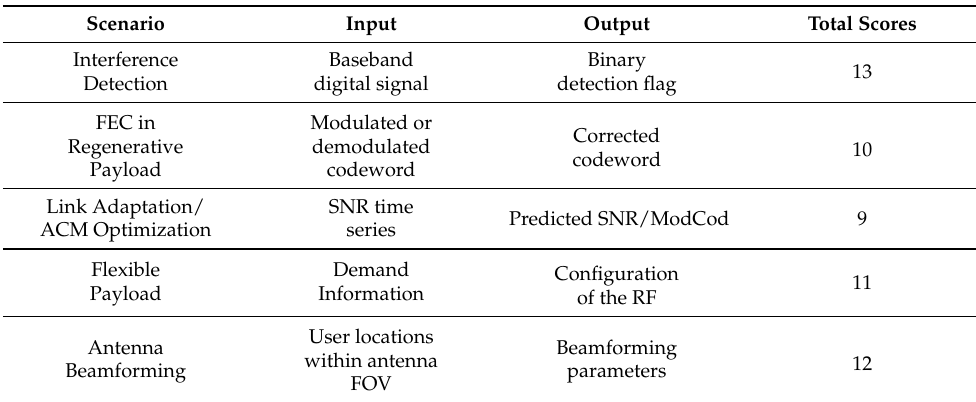
Figure 10. Use cases evaluation. Table 2. Different scenarios